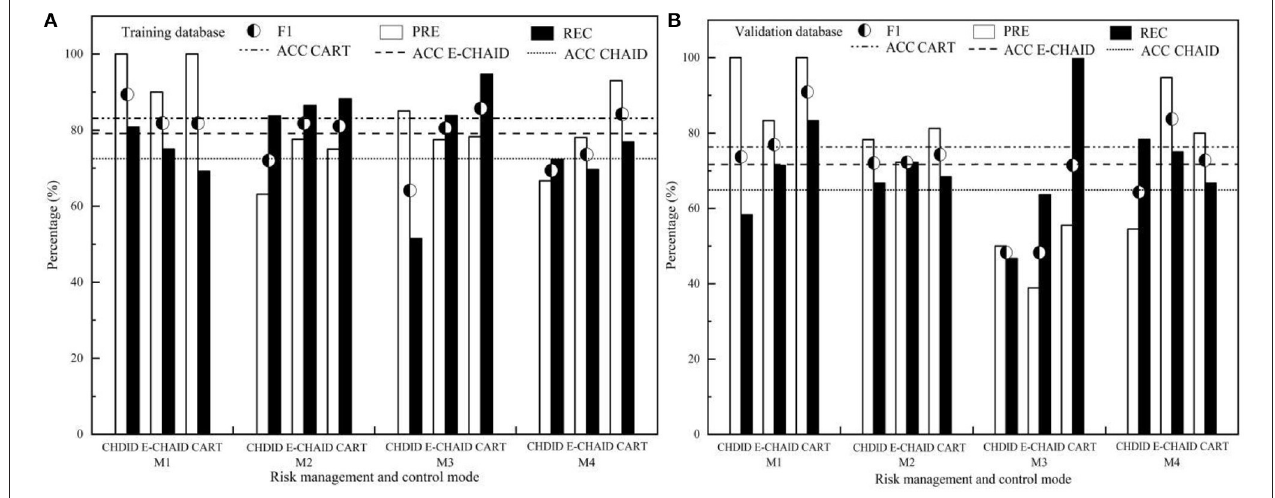
FIGURE 5 | The prediction performance evaluation for DT of CHAID, E-CHAID, and CART [ (A) training database; (B) validation